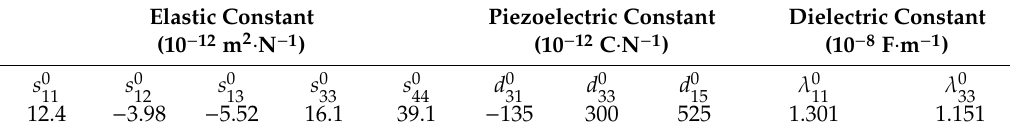
Table 1. Elastic, piezoelectric and dielectric constants of PZT-4 materials